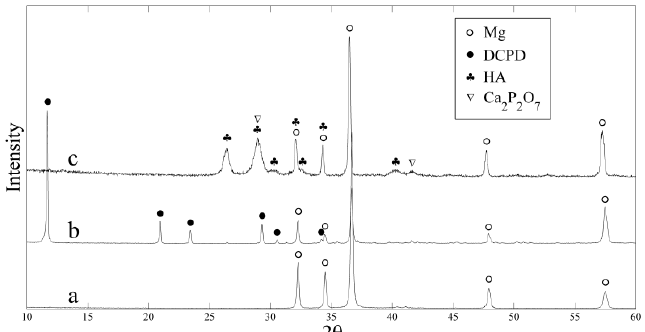
Figure 1. XRD patterns of the substrate and the coatings: ( a ) uncoated ZK60 alloy; ( b ) as-deposited coating; and ( c ) heat-treated